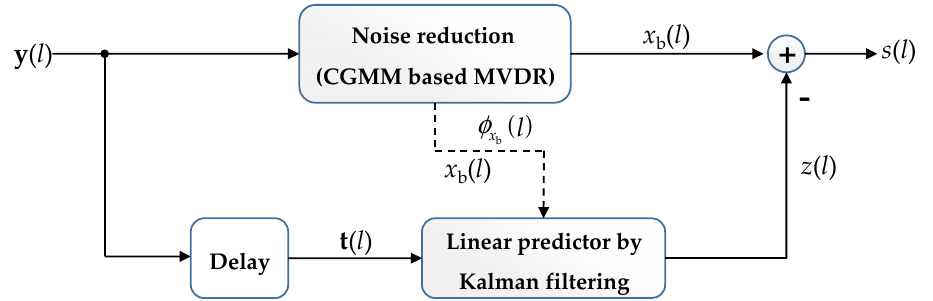
Figure 1. Block diagram of the proposed dereverberation method.